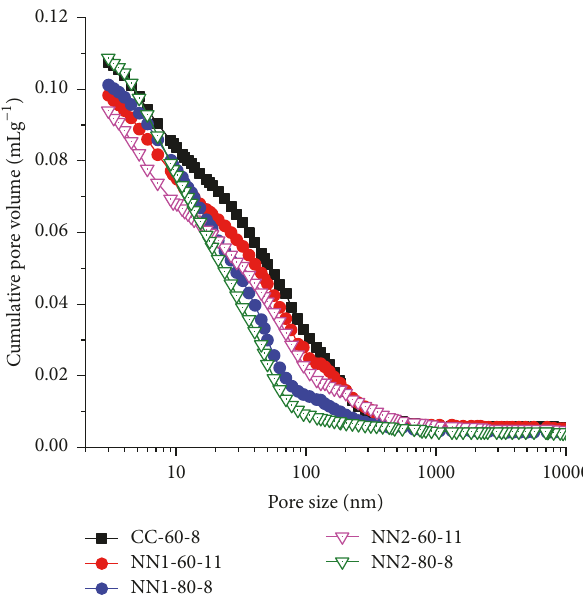
Figure 15: Pore structures of the steam-cured hardened paste with W/B of 0.32 at the age of 90d.